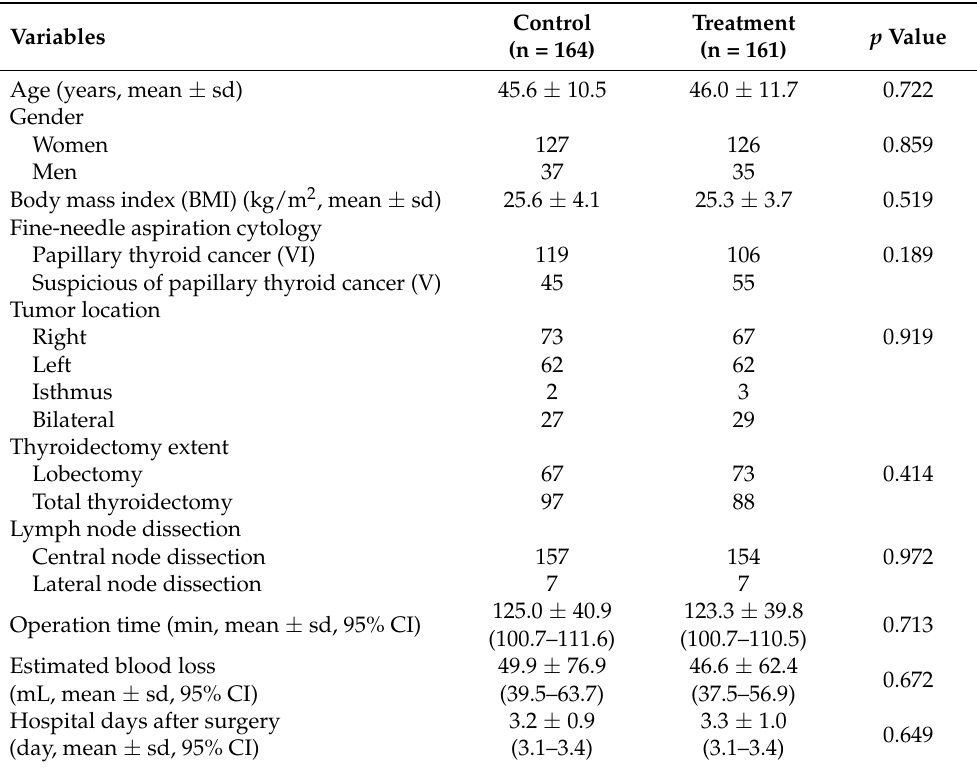
Table 1. Clinical characteristics of the